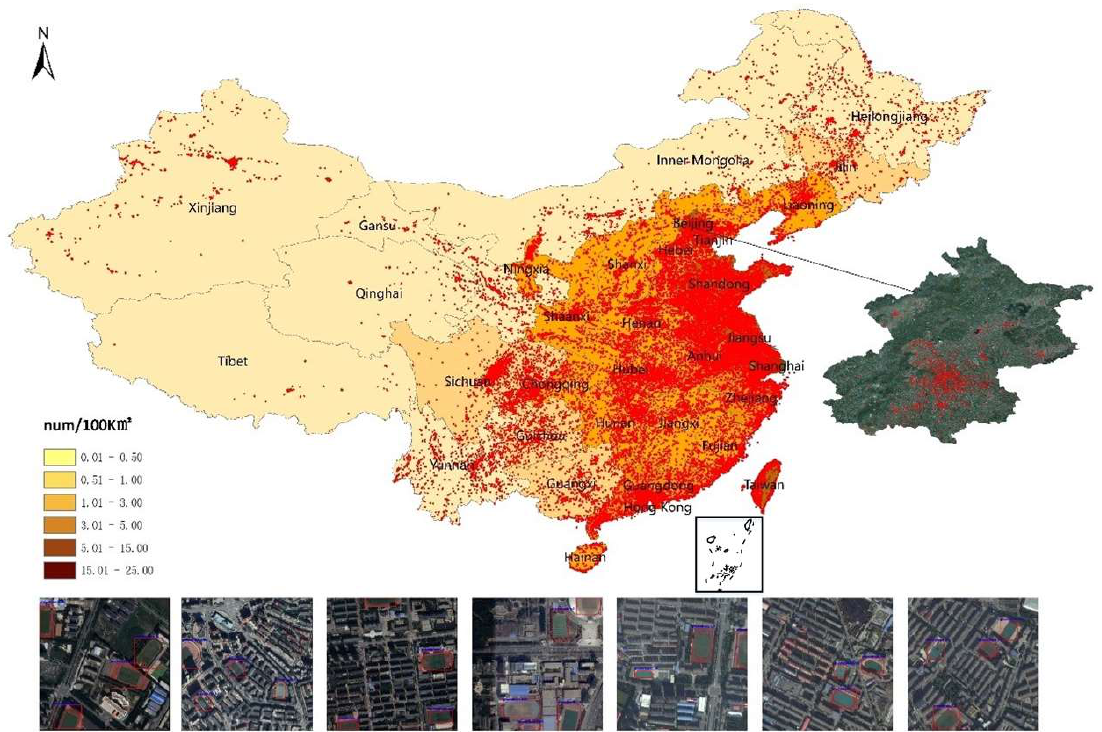
Figure 18. Distribution map of China track and field results detected by using MSF_SSD model.